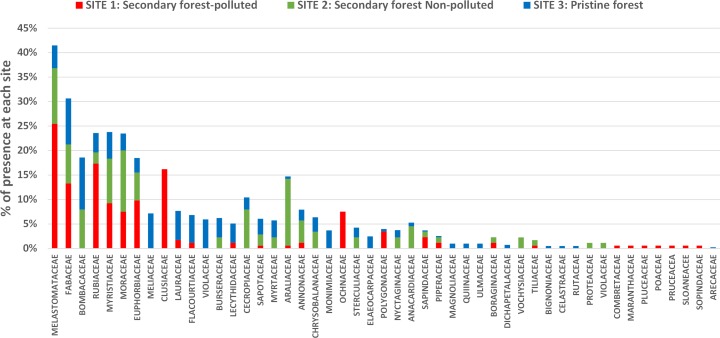
Presence of plant families in the three sites.The percentage represents the proportion of the plant families at each site.